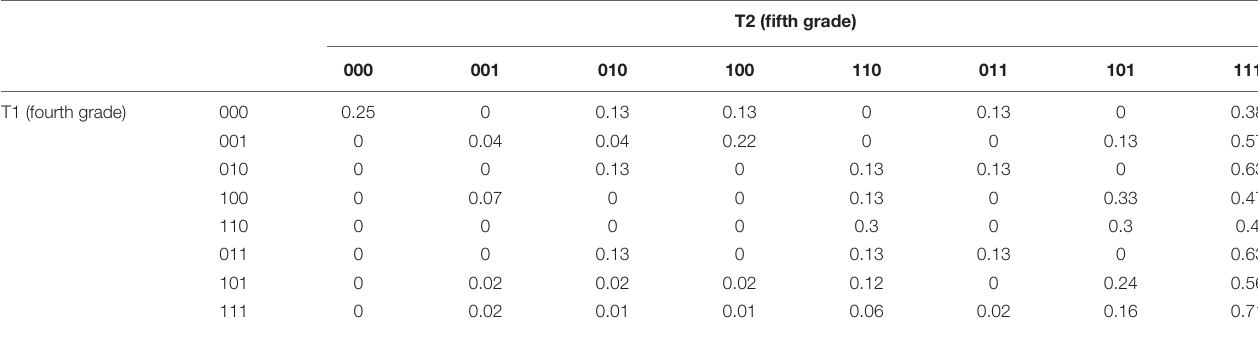
TABLE 10 | Transition probability matrix of attribute mastery